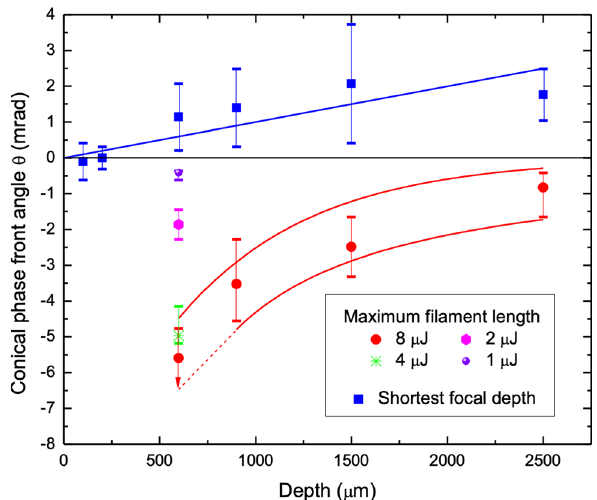
Figure 7. Laser processing windows for forming long uniform filaments and minimizing depth of focus, optimized by conical phase front angle. Conical phase front angle marking optimal laser processing windows for generating long and uniform filament tracks (non-square) or minimizing the track length (square) as plotted over shallow to deep focussing depth. For generating long and uniform filament tracks, an increasingly concave phase front is preferred as laser pulse energy increases from 1 to 8 µJ for 600 µm depth, and as focal depth decreases from 2500 to 600 µm. Respective vertical bars indicate angle ranges for reaching 90% of the maximum observed filament length. In contrast, convex phase fronts with monotonically increasingly conical angle yielded the shortest track length for depth increasing from 100 to 2500 µm. The data follow the solid blue line which marks the conical angle θ opt (z) simulated to minimize the DOF by compensating for increasing surface aberration with increasing depth (z). The blue bars represent the angle range beyond which longer tracks were